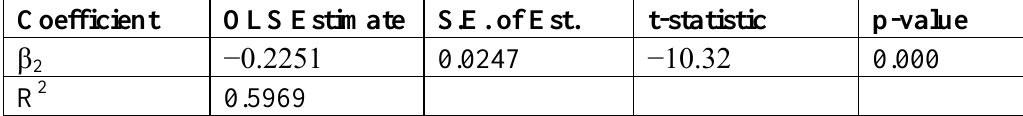
Table 4. OLS Estimates of Model Equation (7) 1 .